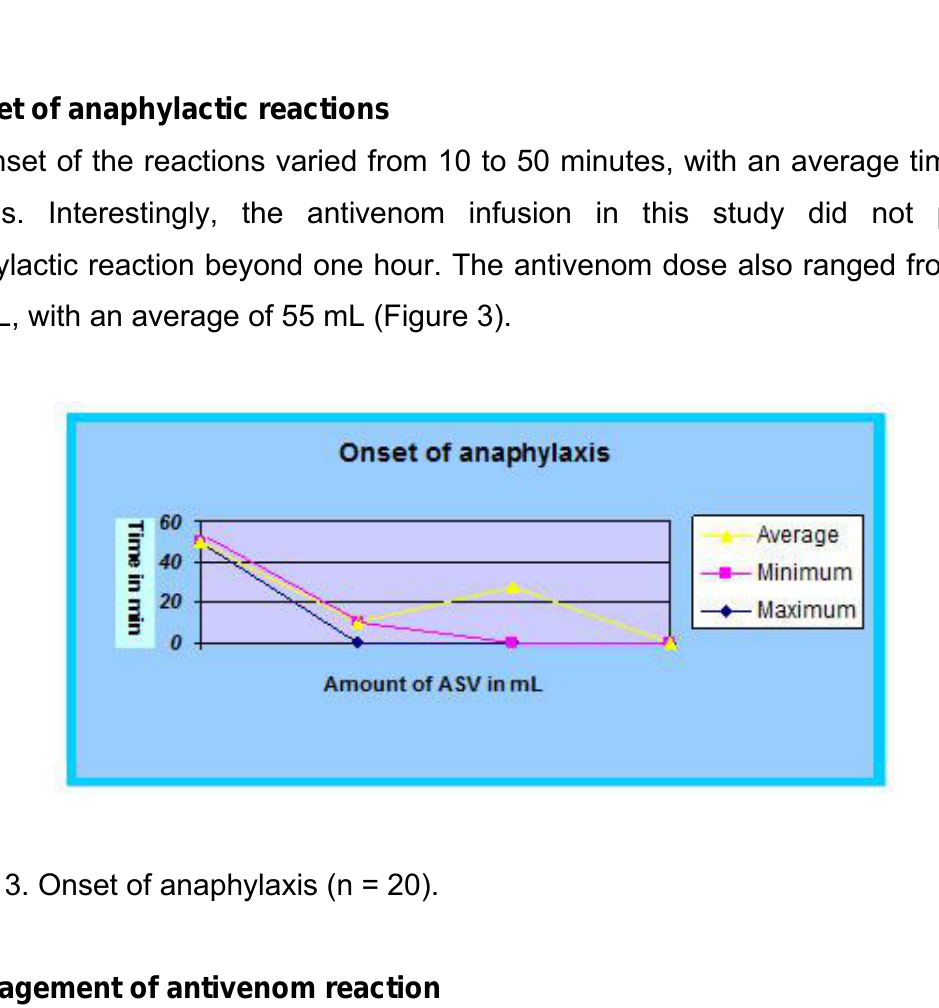
Figure 2. Clinical presentations of anaphylaxis.